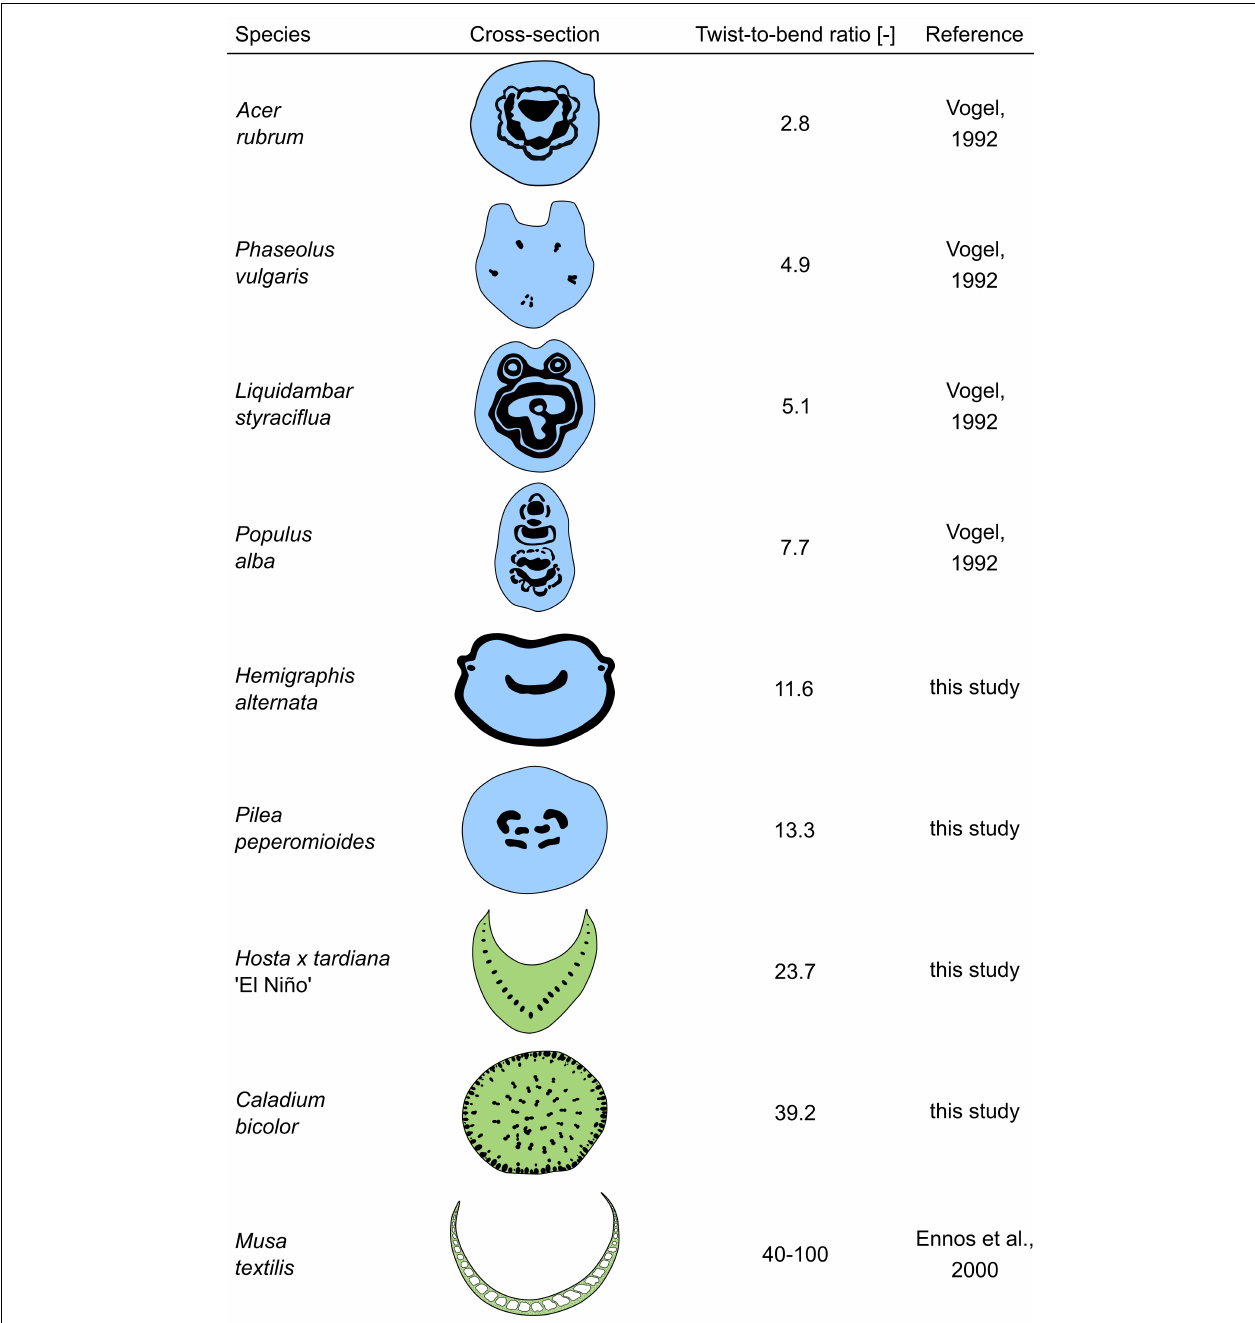
FIGURE 6 | Schematic drawings of the cross-sectional geometries and strengthening tissues (black) of various petioles and their corresponding twist-to-bend ratios. The cross-sectional schematics are colored in blue for dicotyledons and in green for